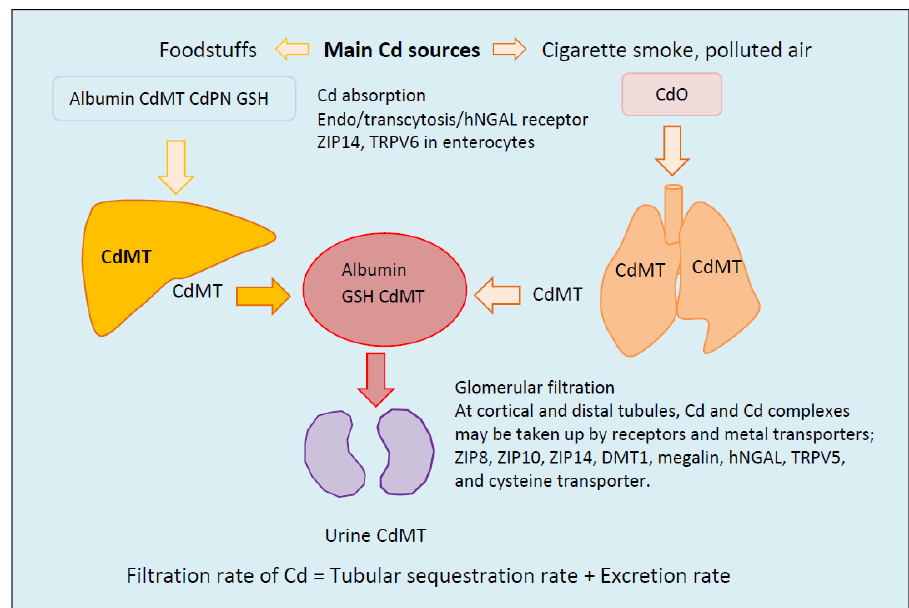
Figure 1. A schematic diagram showing cadmium uptake, transport and urinary excretion. Dietary Cd is absorbed and transported via the hepatic portal system to the liver, where it induces the synthesis